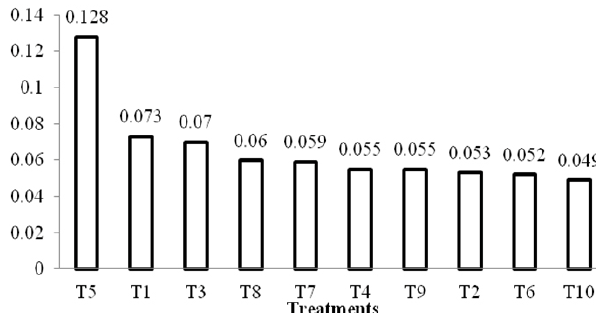
Fig. 4. Mean trichome